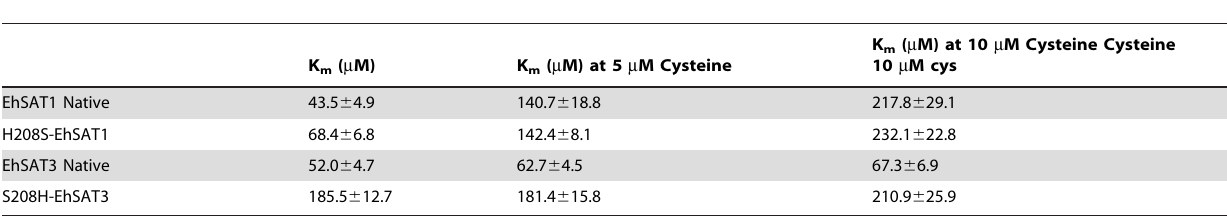
Table 3. Comparison of K m for both native and mutant proteins of EhSAT1 and EhSAT3 at different cysteine concentrations.